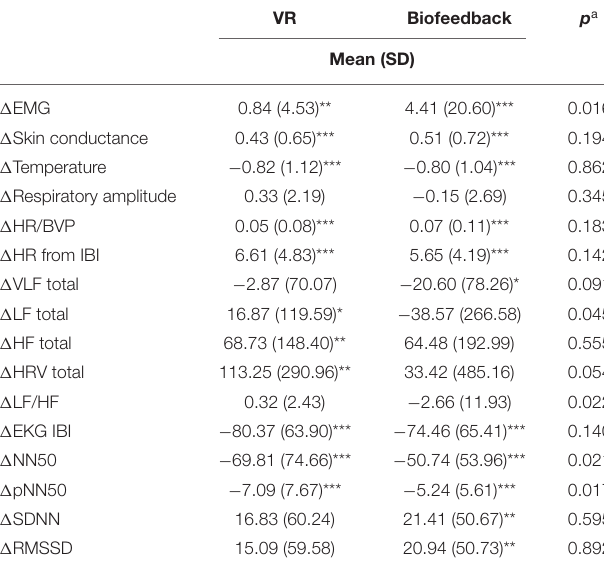
TABLE 3 | Changes of physiological parameters from the stress phase to the TABLE 2 | STAI-X1 and NRS for the study procedure according to the type of relaxation phase according to type of relaxation session ( n = 74). relaxation session ( n = 74). VR Biofeedback p a